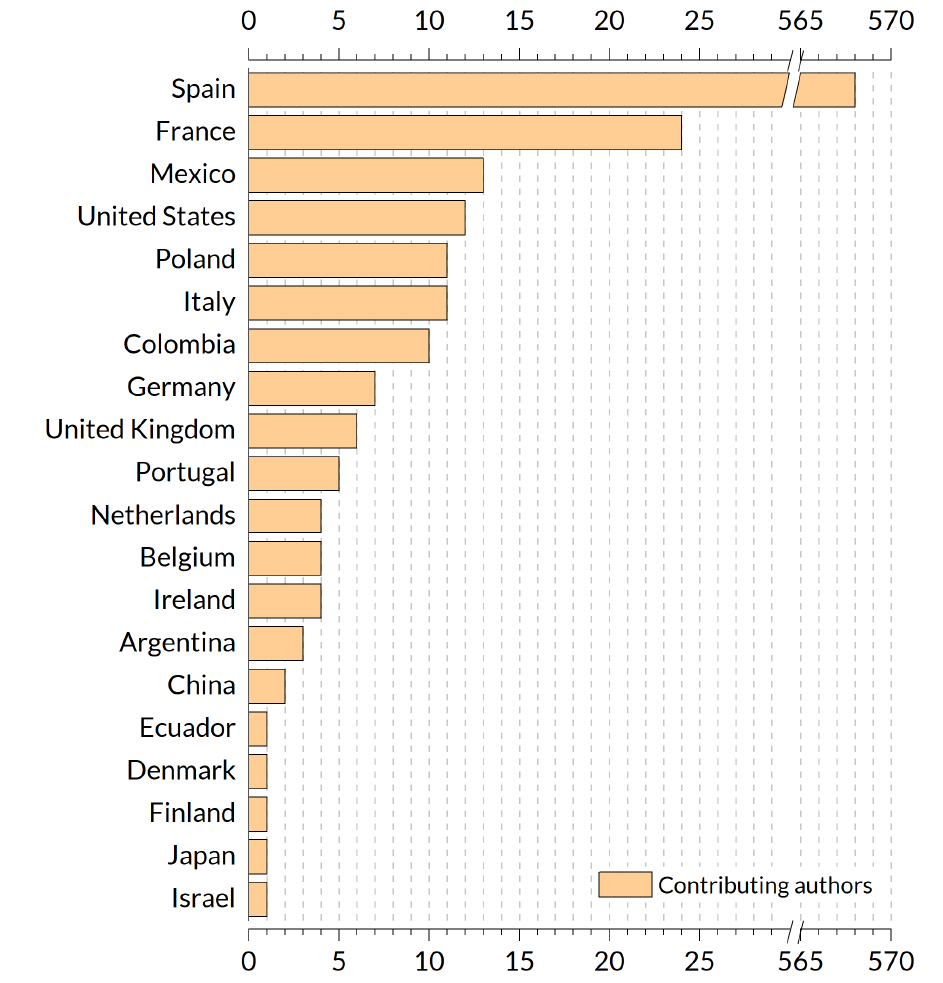
Figure 7. Countries where contributing authors at RNO2021 work.